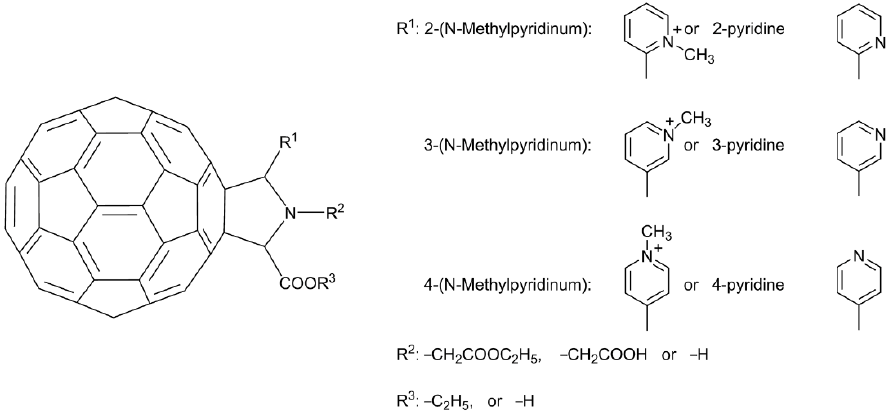
Figure 10. Structure diagram of fullerene pyrrolidine derivatives ( 29 – 41 ). Table 3. HIV-RT inhibitory activity and cytotoxicity of fullerene pyrrolidine derivatives ( 29 – 41 ).